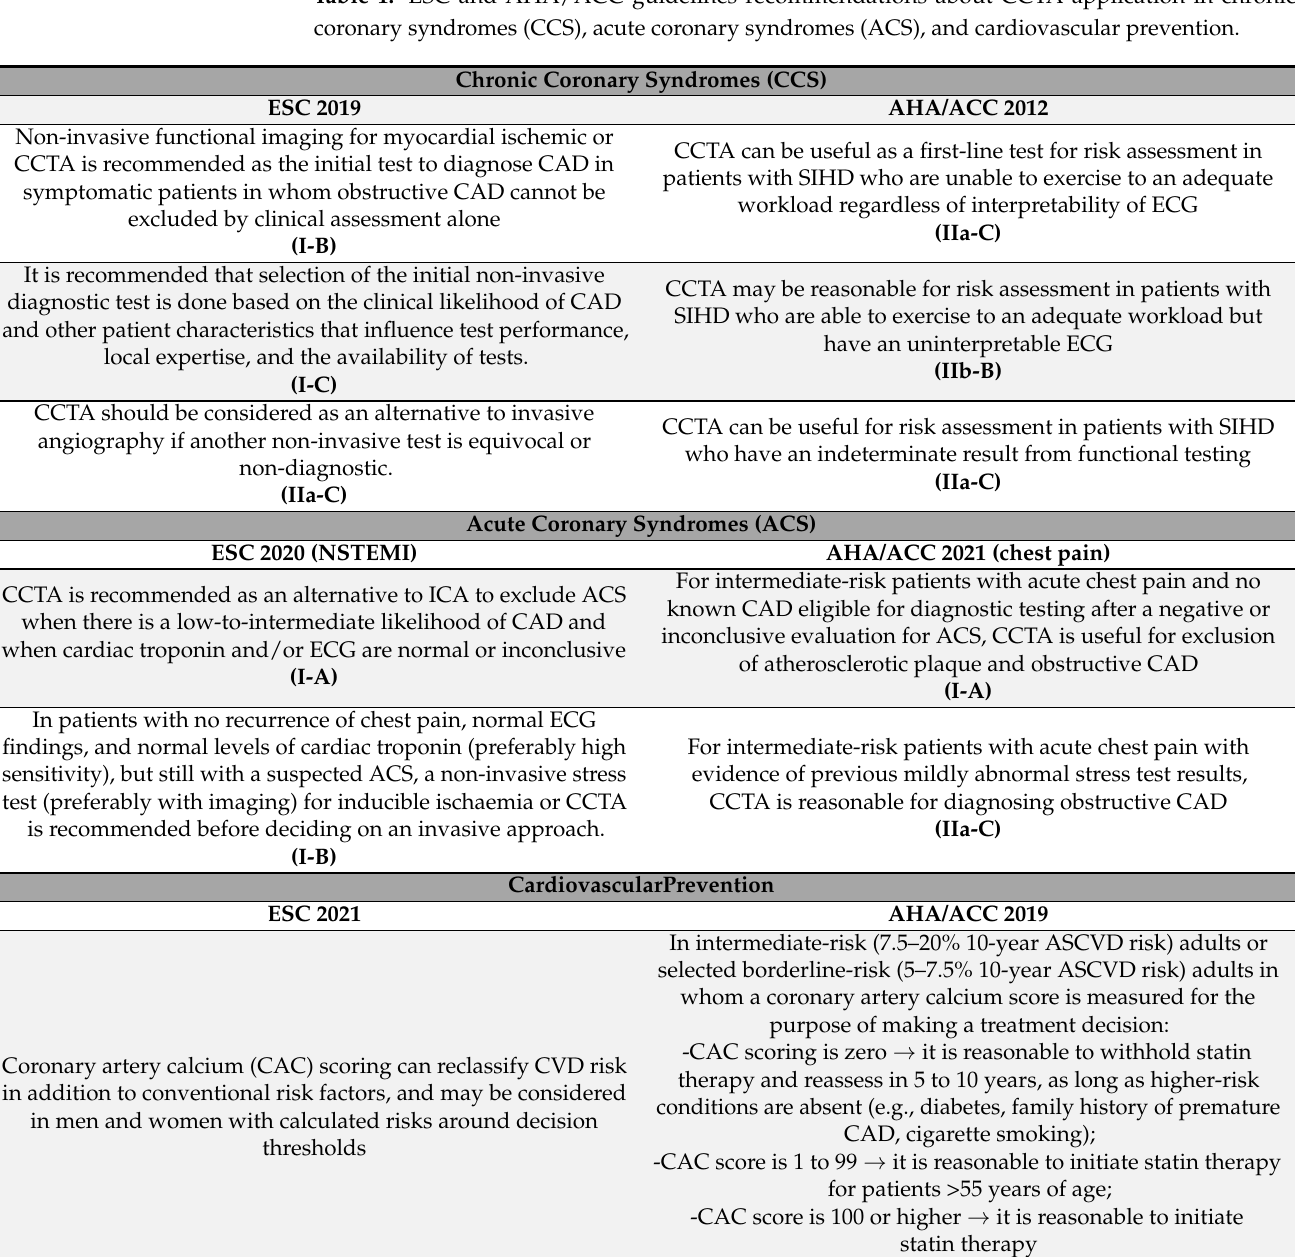
Table 1. ESC and AHA/ACC guidelines recommendations about CCTA application in